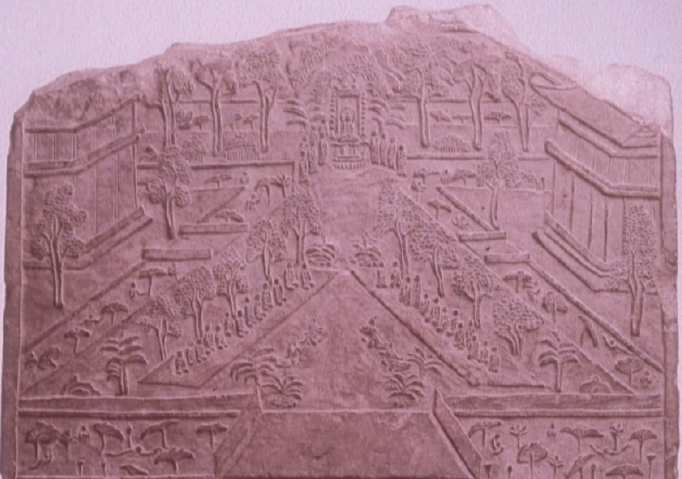
Figure 3. West Pure Land, Maijishan 127, early-sixth-century Gansu.